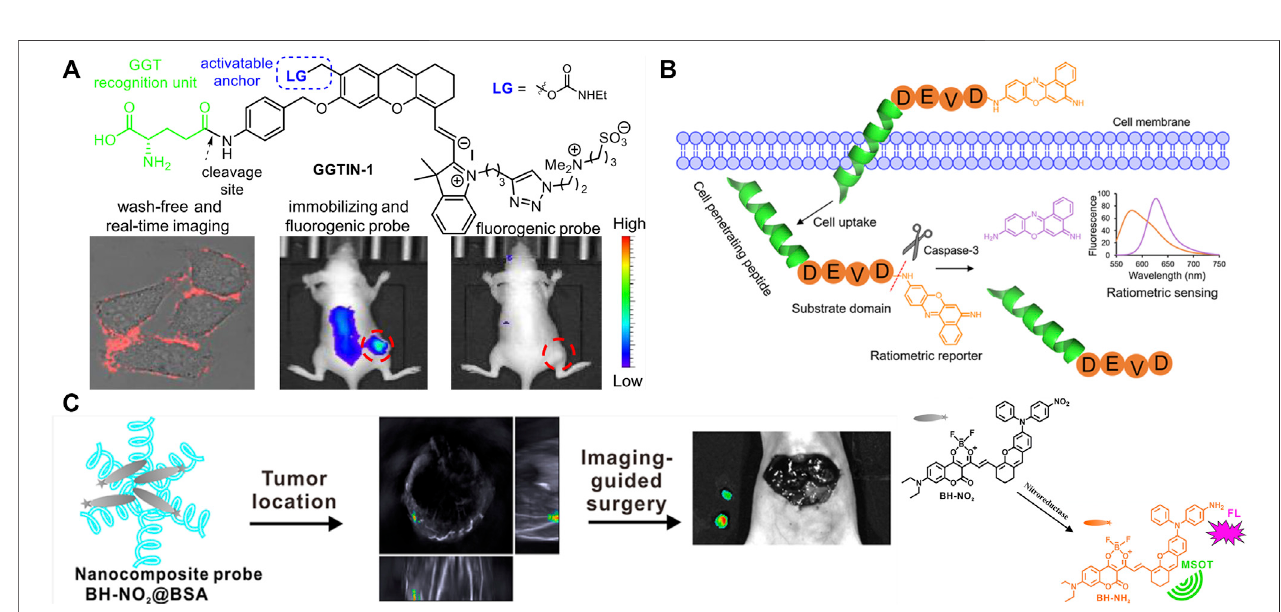
FIGURE 2 | Design strategy and application of multifunction enzyme-activated probes with single enzyme. (A) Design of GGT-activated self-immobilizing fl uorophore and its real-time imaging in mice [adapted with permission from Li et al. (2020b) Copyright © 2020, American Chemical Society]. (B) Design of Casp3- activatablecell-permeable fl uorophoreanditsapplicationonapoptosisimaginginHeLacells[adaptedwithpermissionfromJinetal.(2021)Copyright©2021,American ChemicalSociety]. (C) Designofdual-modalimagingprobeanditsapplication onimaging-guidedsurgeryinmice [adapted withpermissionfromZenget al.(2020) Copyright © 2020, American Chemical